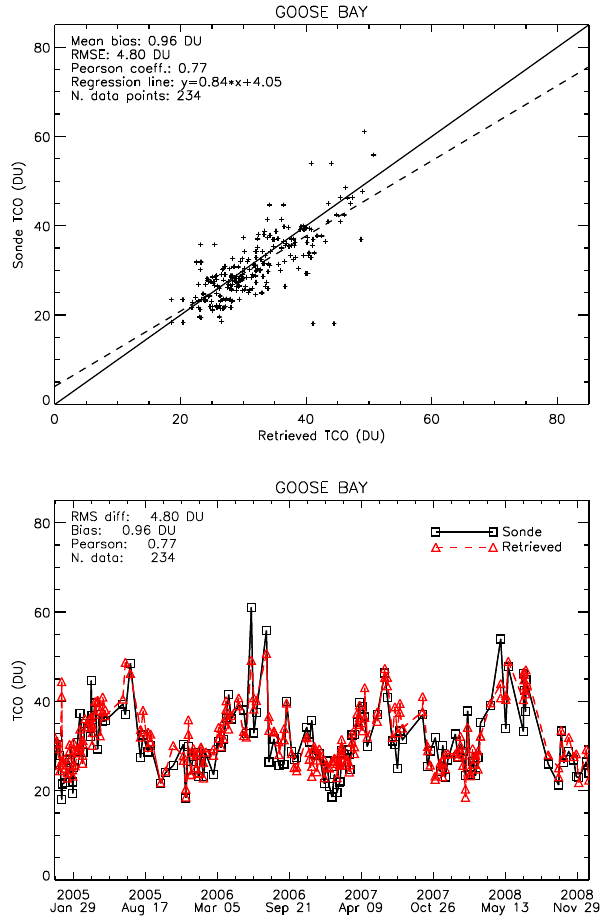
Fig. 6. Scatter plot (top) and time series (bottom) of retrieved and ozonesonde TCO at Goose Bay (Canada).